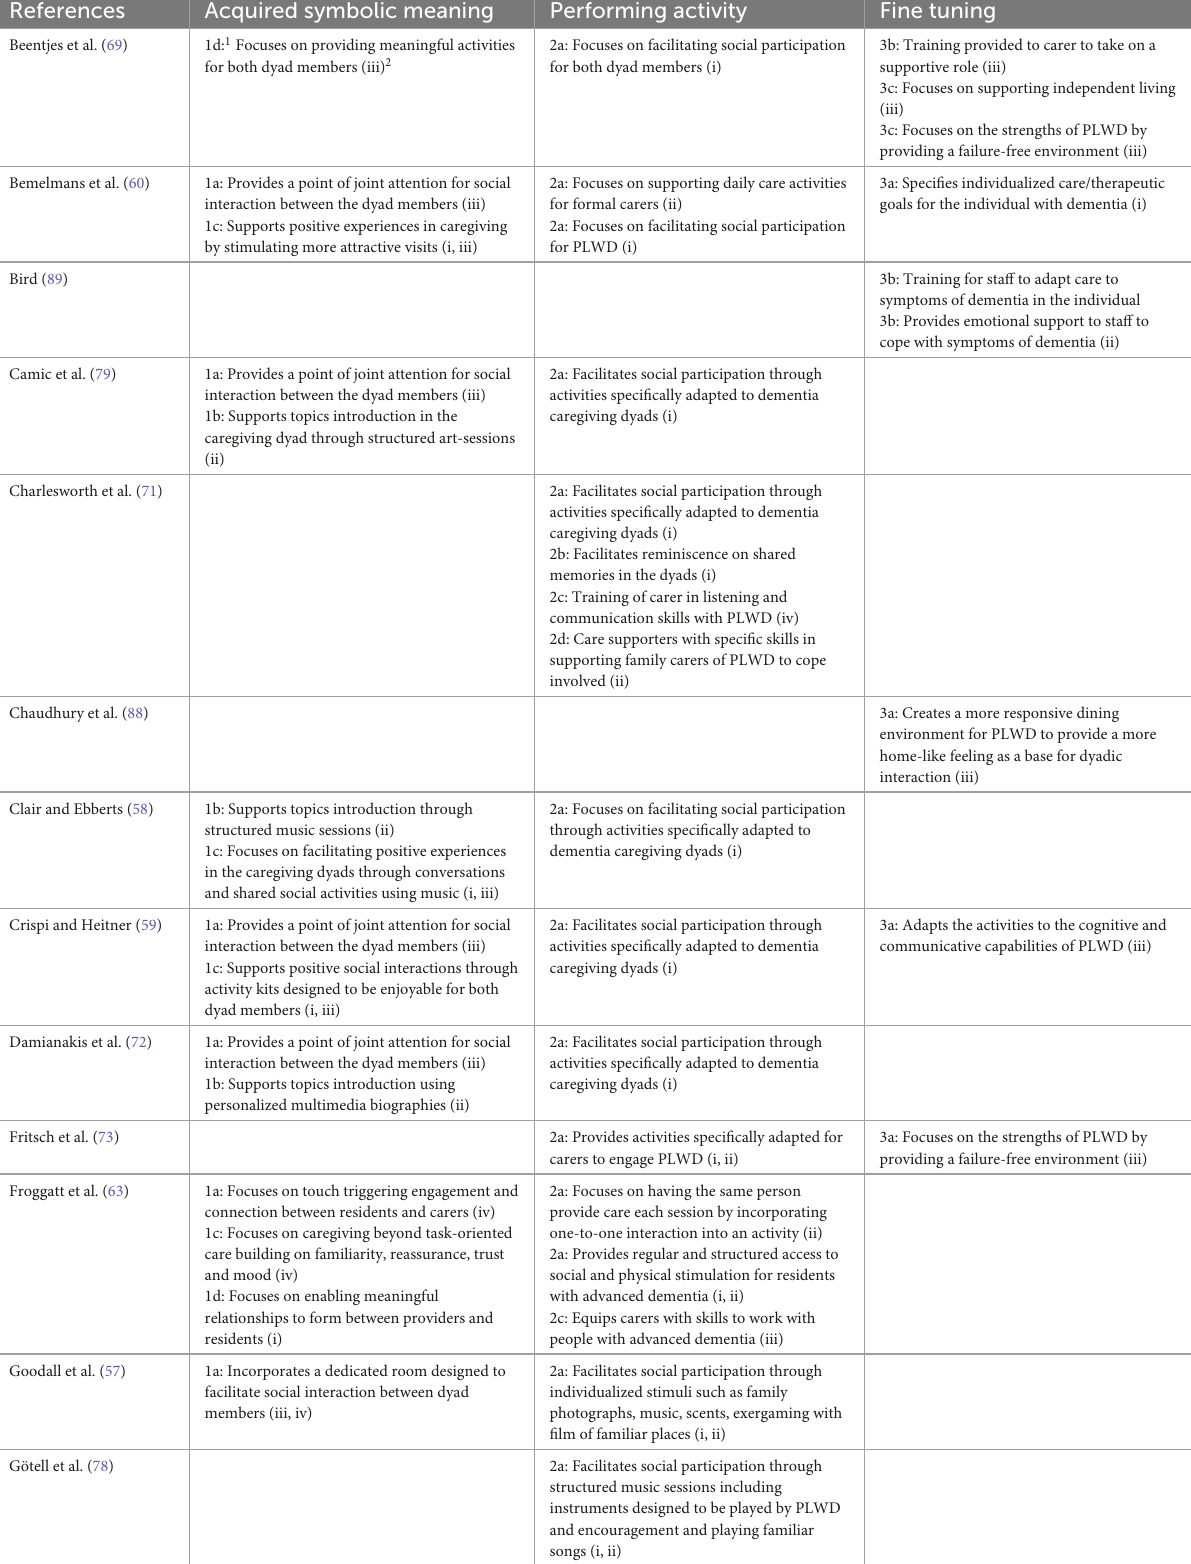
TABLE 4 Identified intervention elements contributing to enrichment in dyadic